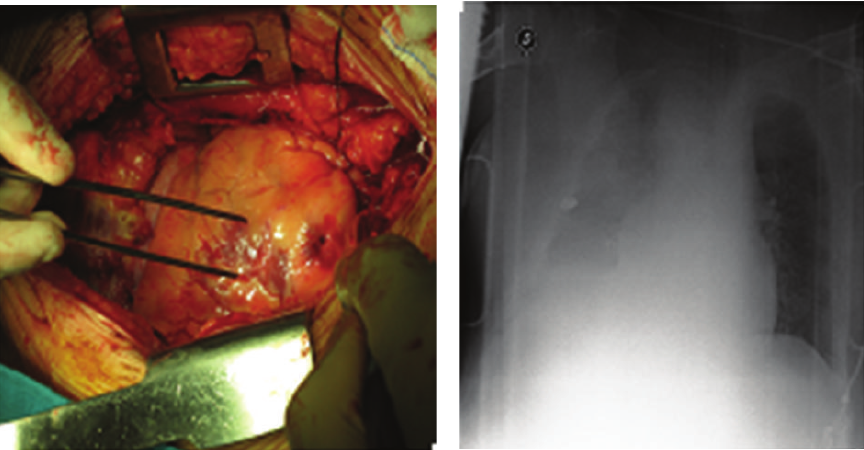
Figure 1: GSW to the right ventricle. Chest X-ray showing a bullet in the right hemithorax and a massive right hemothorax.